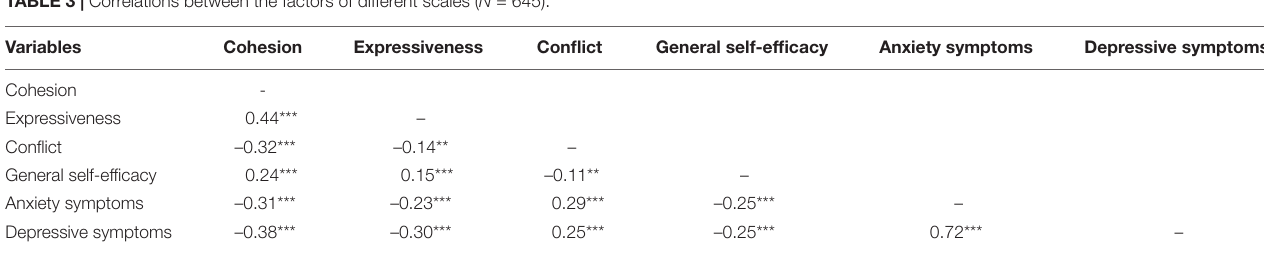
TABLE 3 | Correlations between the factors of different scales ( N =